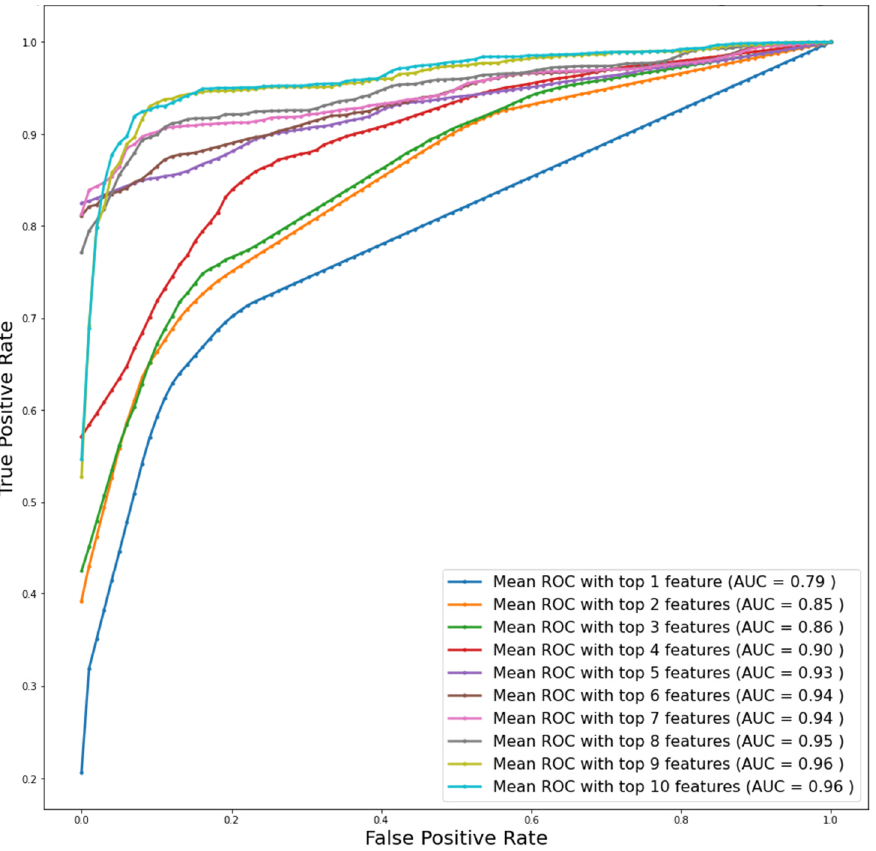
Figure 2. Receiver operating characteristic (ROC) plots for the top-10-ranked features utilizing the MICE data imputation and logistic regression classification techniques for extra tree feature selec- tion algorithms.